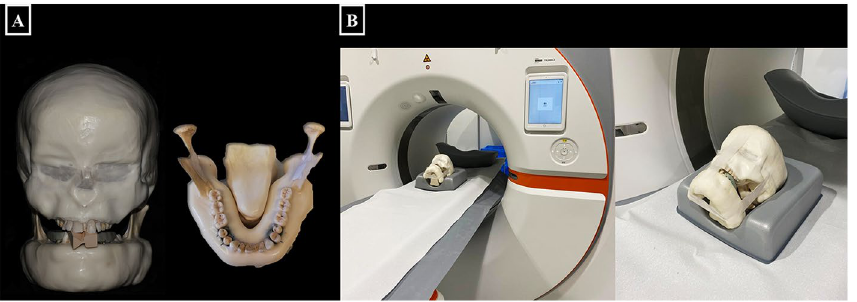
Figure 1. Anthropomorphic phantom scanning. ( A ) Anthropomorphic phantom composed of a dry human skull and a full-dentate mandible covered with Mix-D with a tongue model made with Mix-D; ( B ) Positioning of the anthropomorphic phantom in the PCCT NAEOTOM Alpha